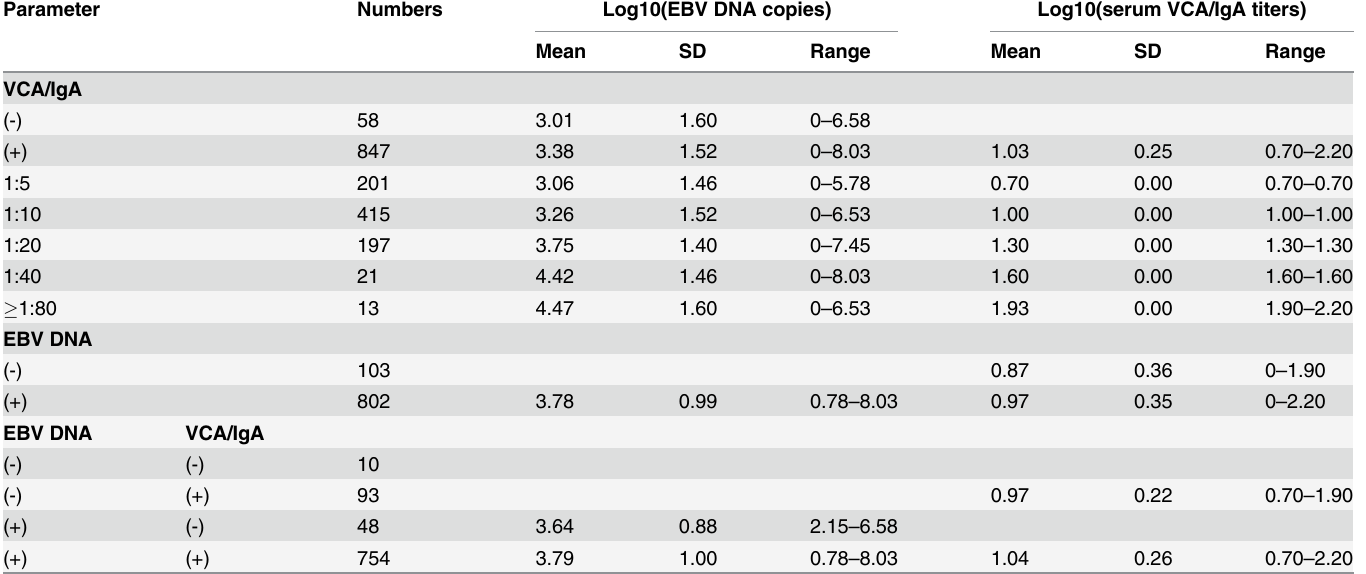
Table 2. Nasopharyngeal EBV DNA load and serum VCA/IgA titers in seropositive high-risk population.